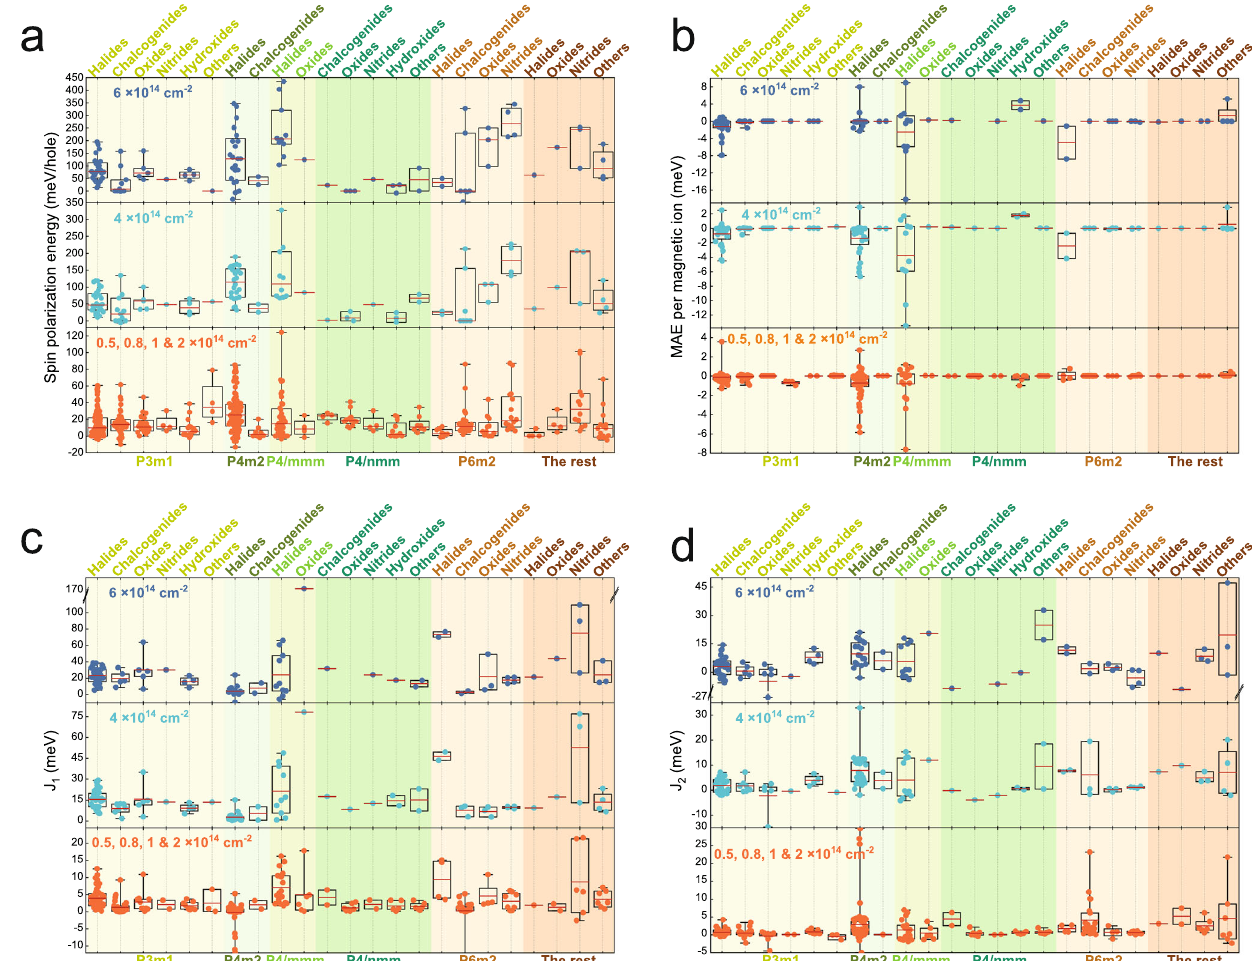
Fig. 3 Distribution of spin-polarization energies, magnetic anisotropic energies (MAE) per magnetic ion and magnetic exchange interaction parameters of the 2DHDFM. Box plots of the spin-polarization energies ( a ) magnetic anisotropic energies (MAE) per magnetic ion ( b ) nearest-neighbor exchange interaction parameters, J 1 ( c ) and next-nearest-neighbor exchange interaction parameters J 2 ( d ) at speci fi c hole doping density of the 122 2DHDFM, classi fi ed by space group and chemical composition. The box plots show the extrema (whisker tails), interquartile range (box boundaries), and median (red horizontal